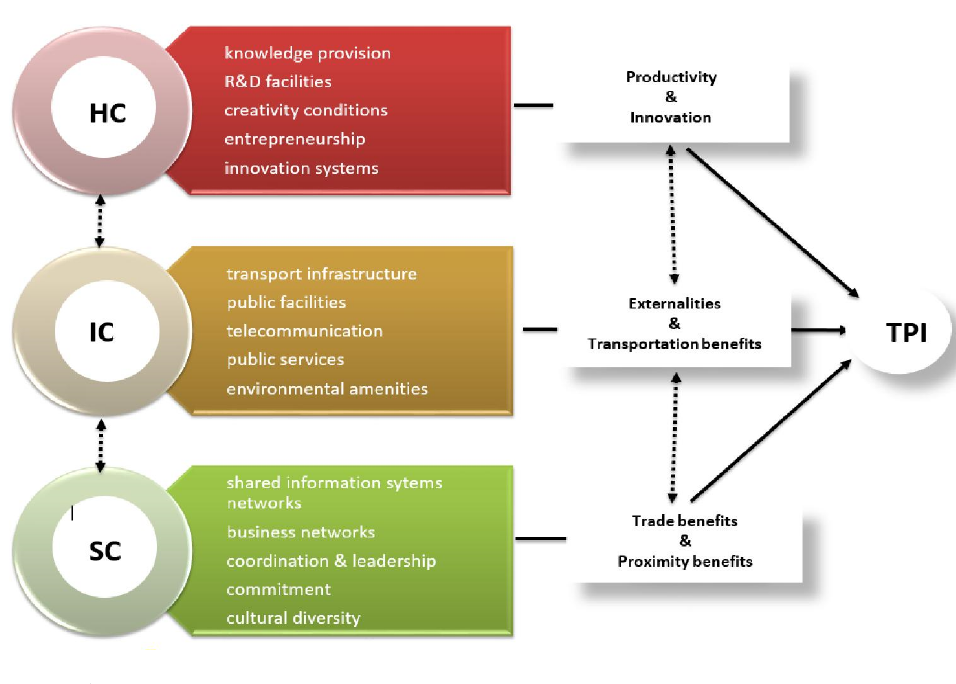
Figure 4: A comprehensive representation of the TPI